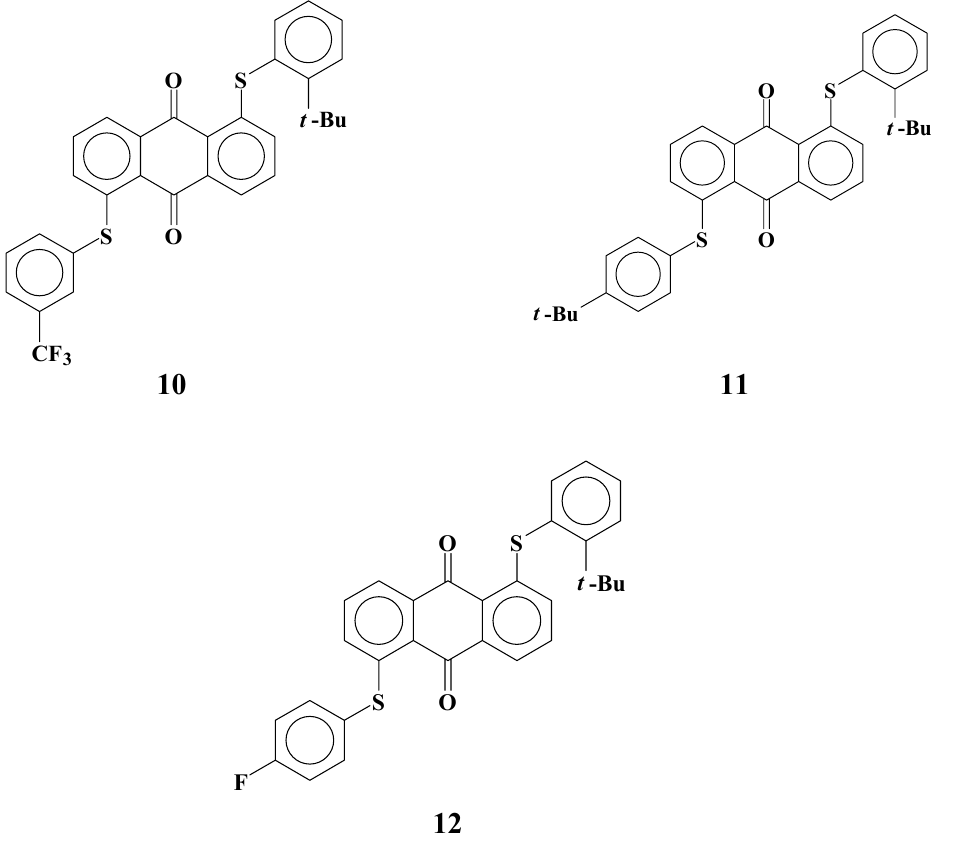
Figure 7. The molecular structures of yellow anthraquinone dyes with an ortho -substituted phenylthio group.